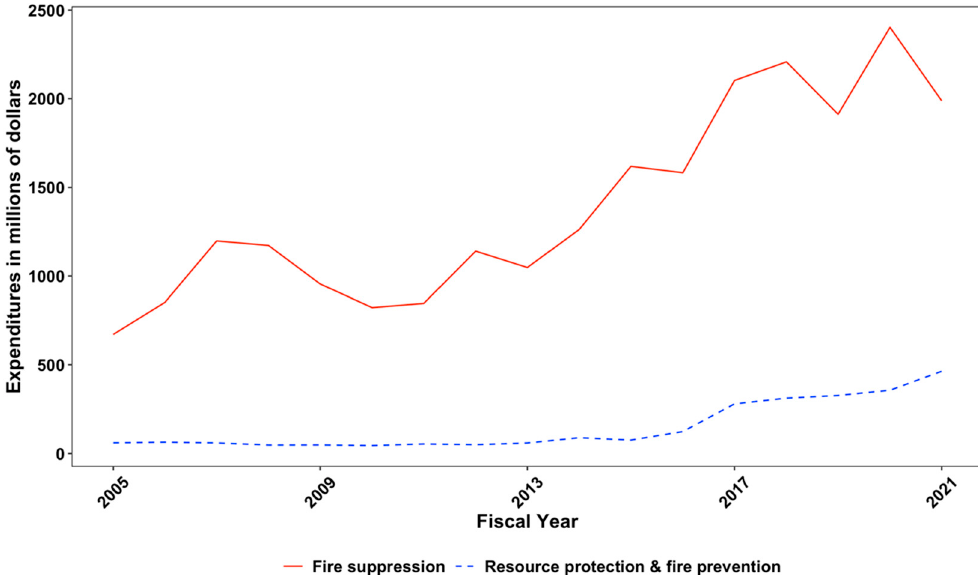
Figure 4. CAL FIRE fire suppression (in red) and resource protection & fire prevention (in blue) expenditures 2005–2021, not adjusted for inflation.